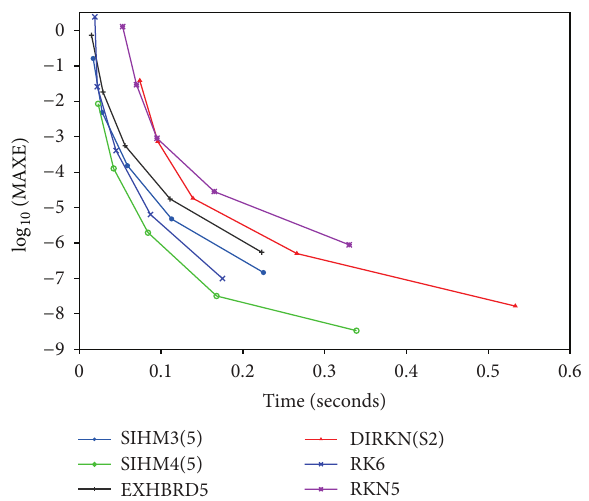
Figure 15: The efficiency curves for SIHM3 (5) and SIHM4 (5) methods for Inhomogeneous problem with ℎ = 0.125/2 𝑖 , 𝑖 = 2,...,6 .